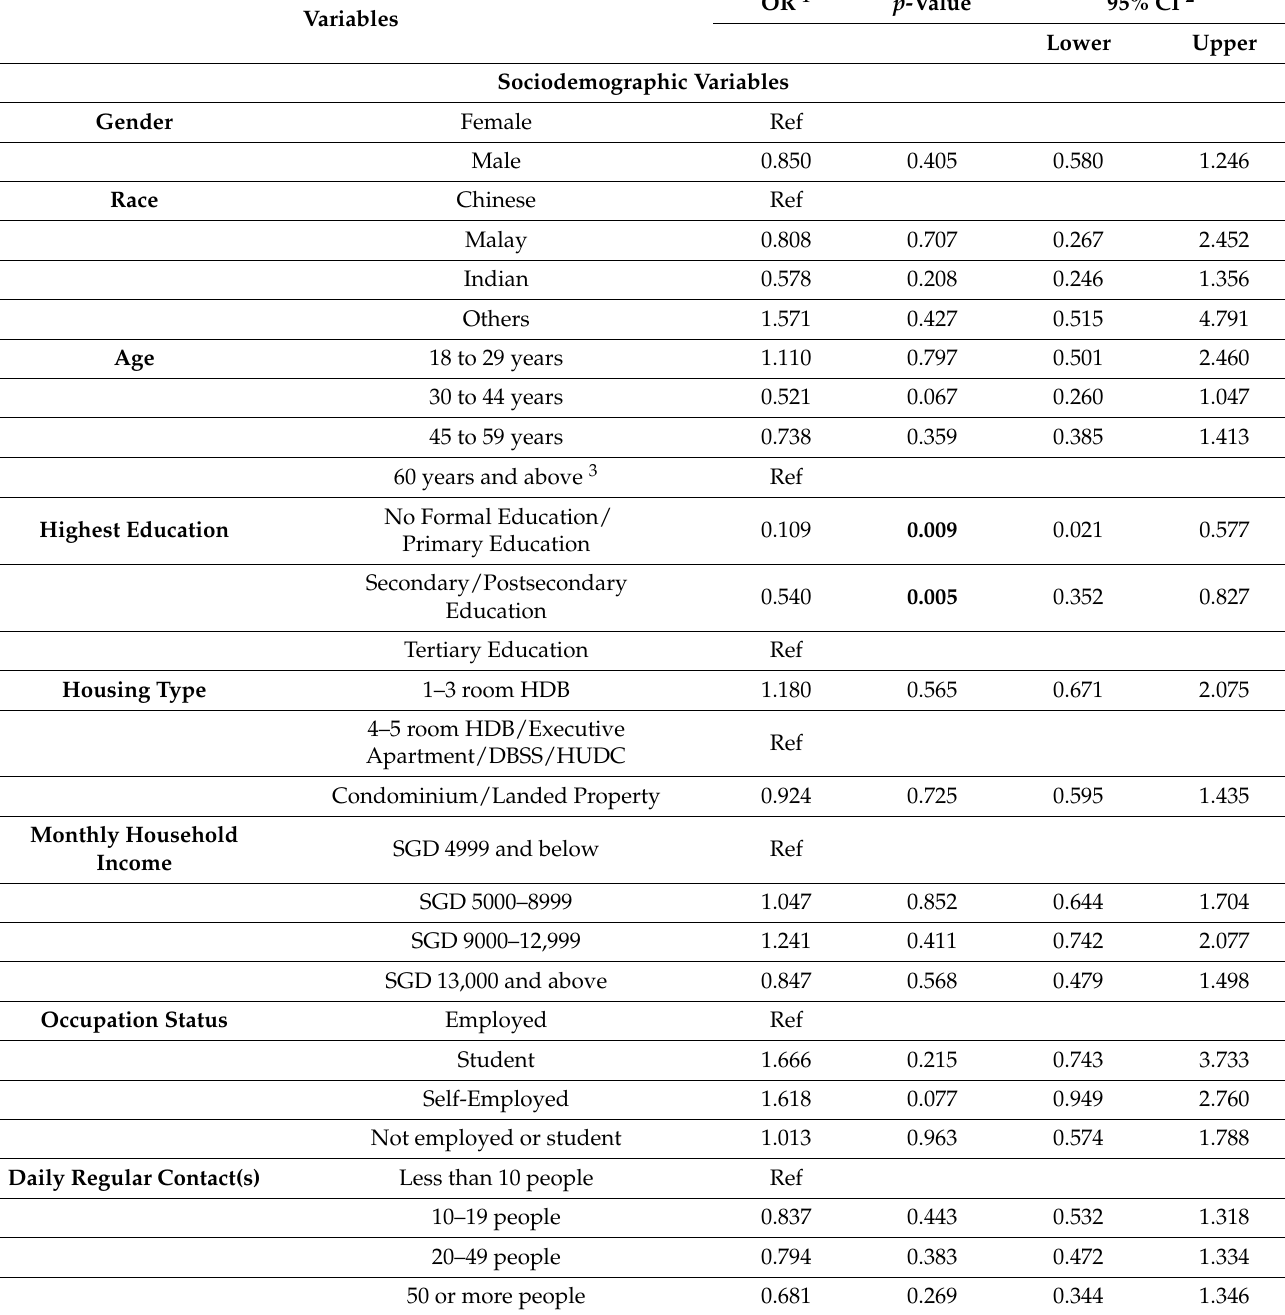
Table 3. Final multivariable binary logistic regression model of the variables of COVID-19 booster vaccine hesitancy, with benefits and concerns as separate variables. OR 1 p -Value 95% CI 2 Variables Lower Upper Sociodemographic